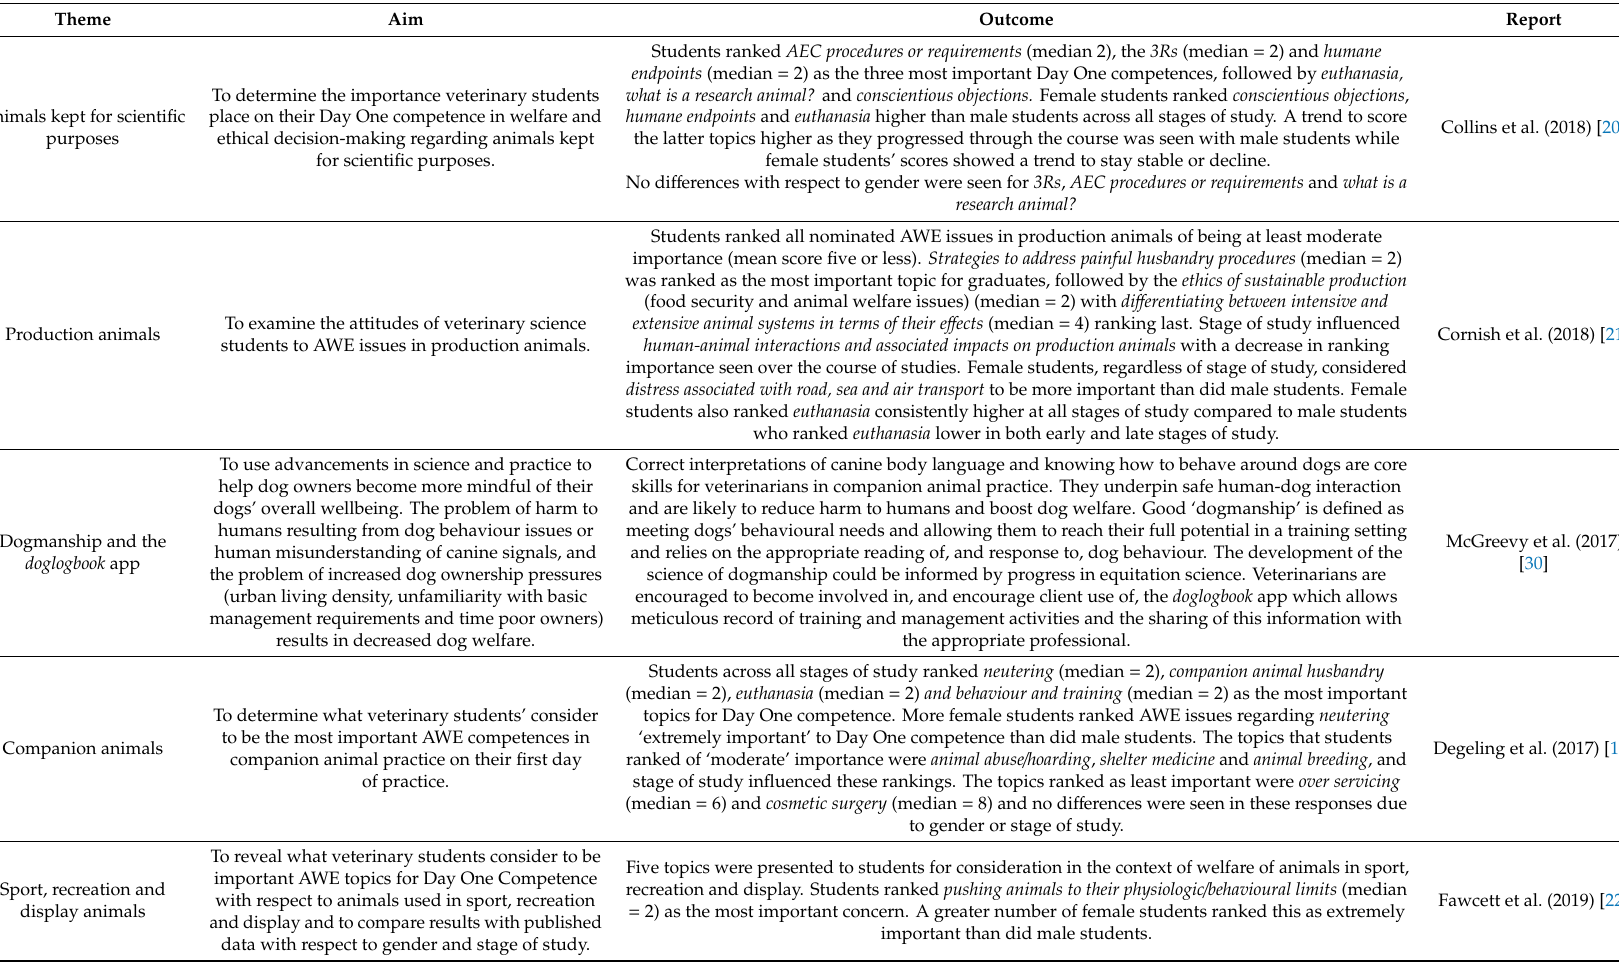
Table 5. Summary reports on students’ opinions on welfare and ethics issues in various areas of veterinary practice and their importance among Day One competences. Theme Aim Outcome Report